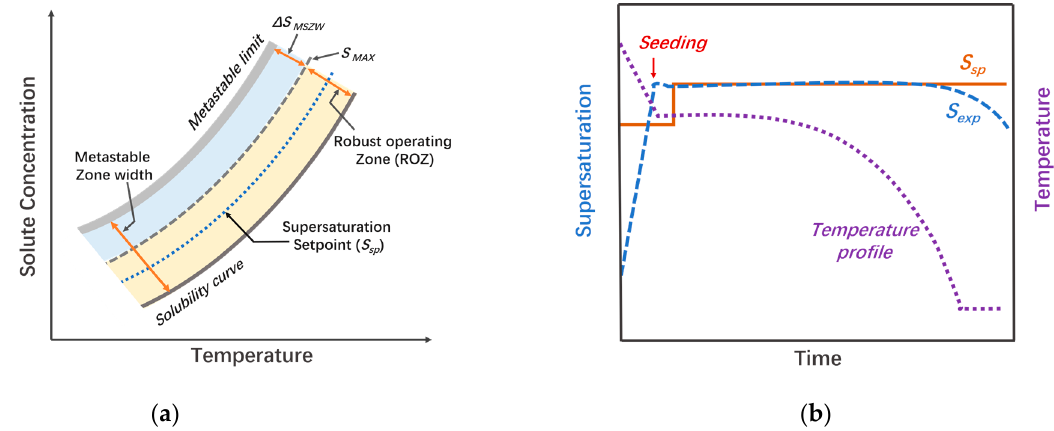
Figure 3. Crystallization phase diagram ( a ); supersaturation and corresponding temperature profiles obtained during the supersaturation control (SSC) process ( b